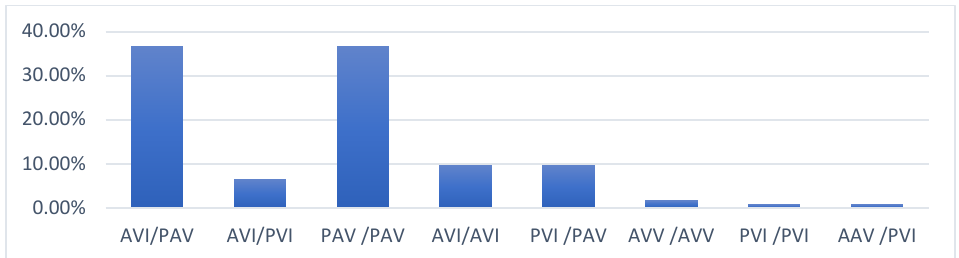
Figure 1. Distribution of TAS2R38 diplotype in group of Polish children recruited to the study.